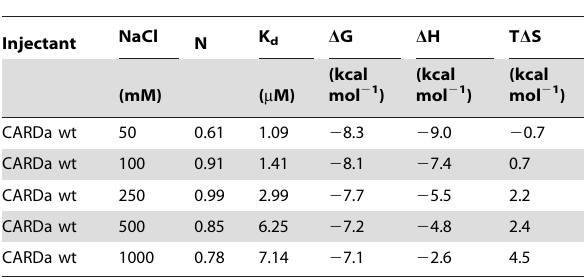
Table 2. Salt dependence of the CARDa-CARDb